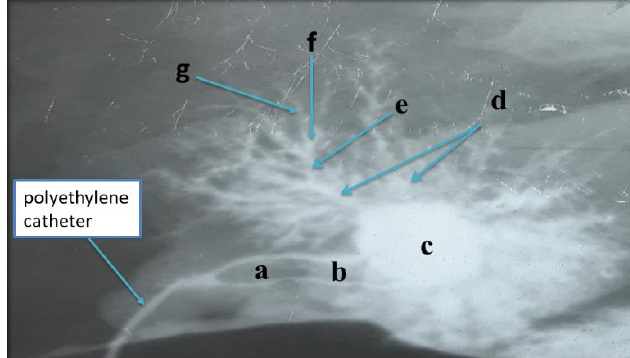
Figure 10. Radiographic image of the quarter in lactating udder (50 mL of Iopromide contrast media) shows: (a) Teat canal (b) Teat sinus (c) Lactiferous sinus, (d) Lactiferous duct, (e) Collecting duct f.Interlobular duct (g)